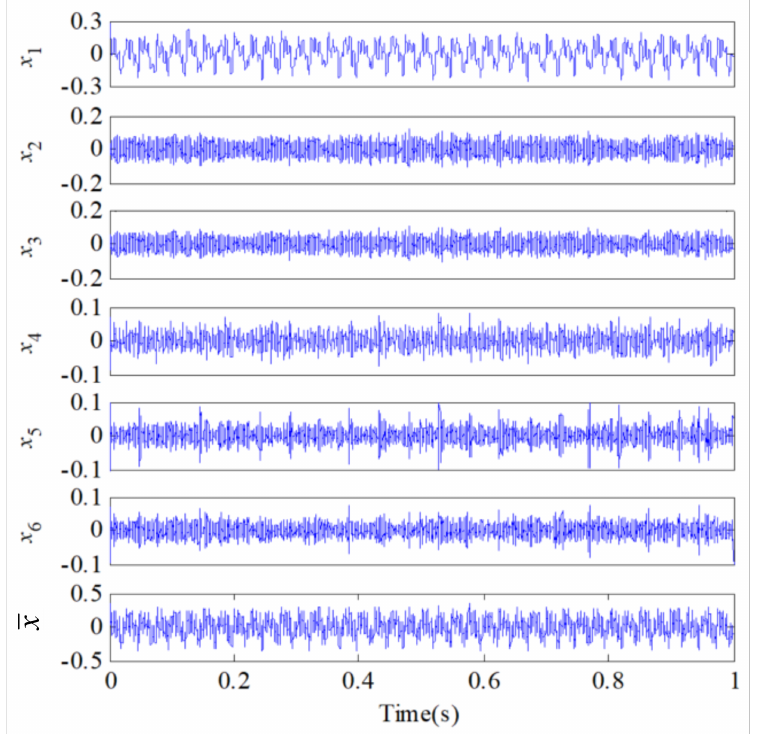
Figure 6. The denoising process based on traditional SVD and the denoising